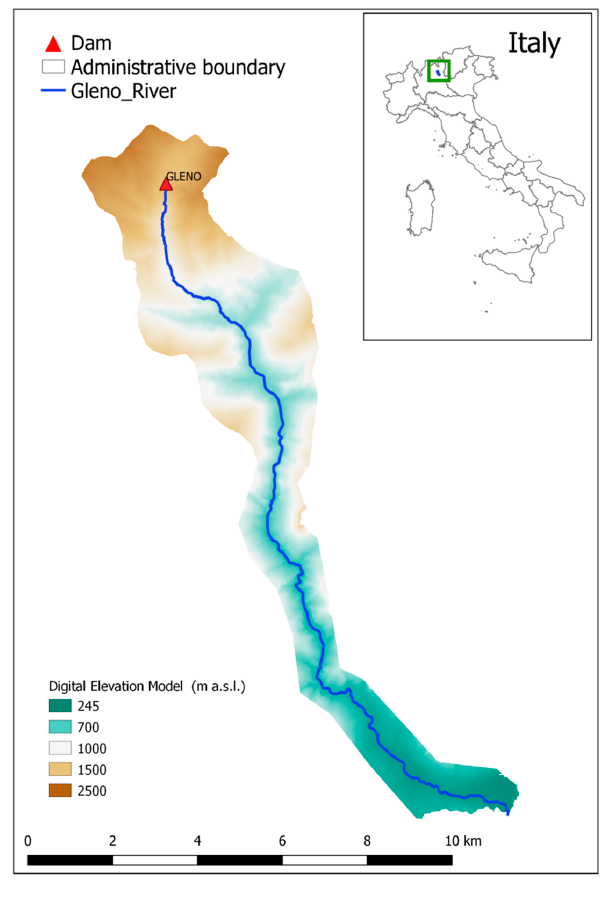
Figure 9. The Gleno dam case study.